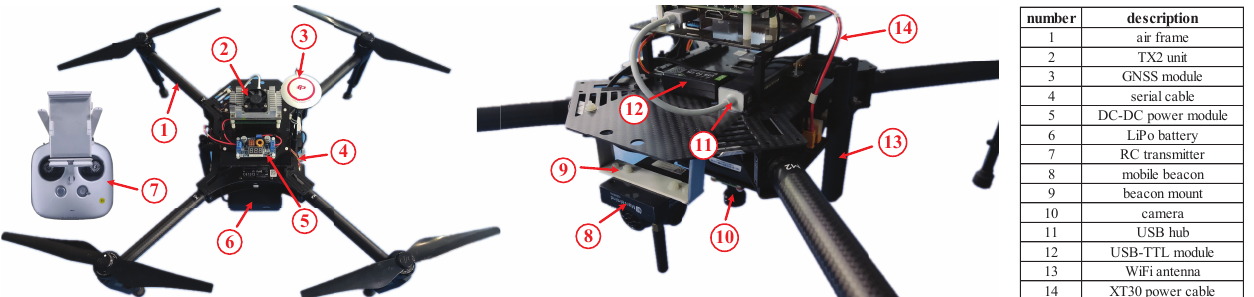
Figure 1. The DJI M100 quadrotor UAV platform and the customized